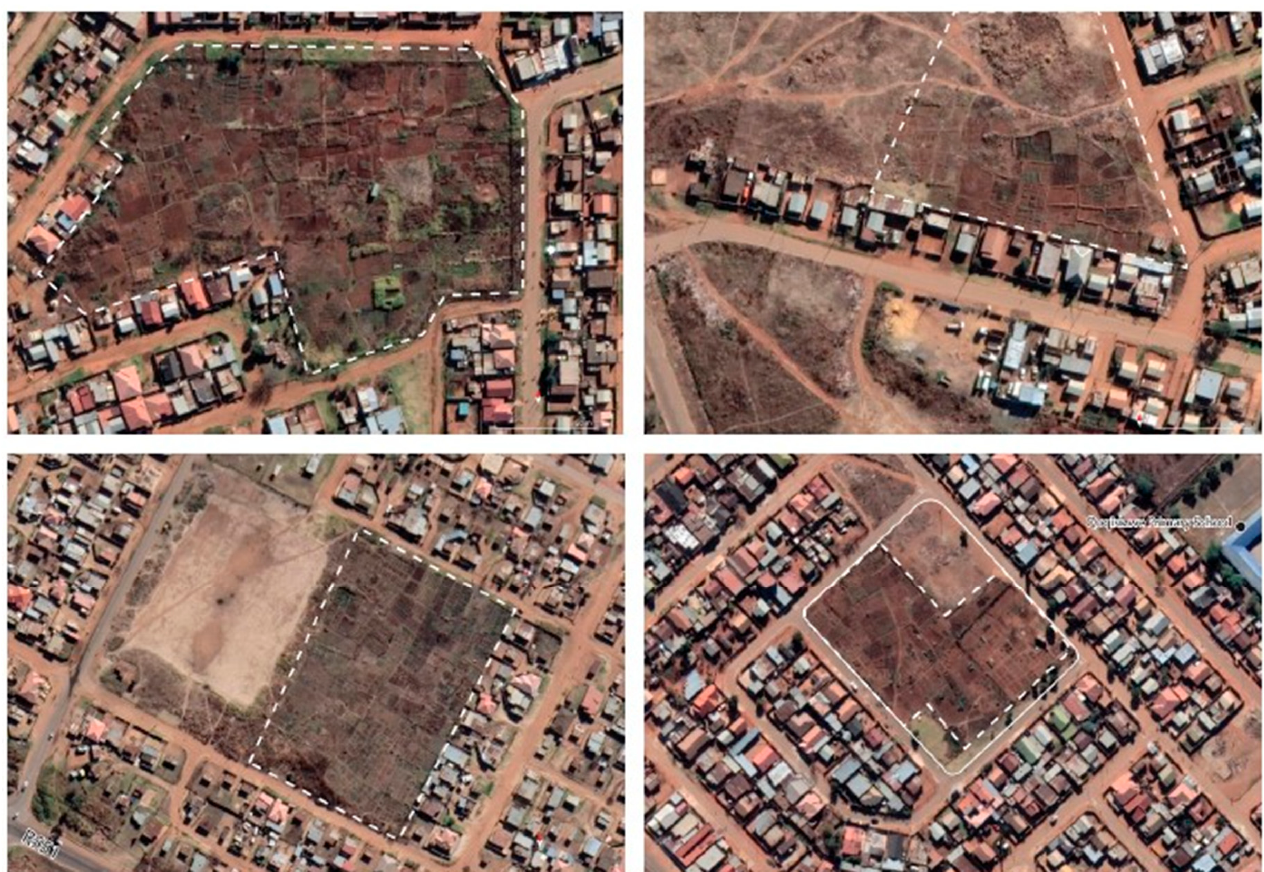
Figure 3. Location of cross-validation sites for highly suitable and moderately suitable.